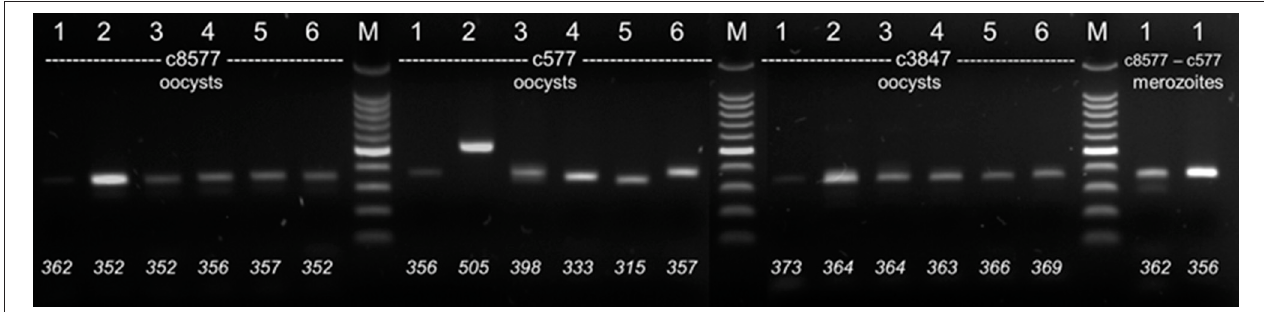
FIGURE 1 | Electrophoretic separation of PCR products (agarose, 2%). DNA from six different C. suis strains (1: Wien-I, 2: Holl 1. 3: Spain 1, 2017 4: Holl 2, 5: DK 1, 6: Spain 1, 2014) were amplified with different primer sets (c8577, c577, c3847) from different stages (oocysts or merozoites). Bottom: Fragment sizes determined by